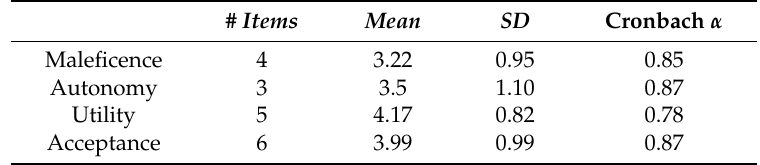
Table 2. Descriptive statistics of the four composite factors used for further statistical analyses ( N = 357). # Items Mean SD Cronbach α Maleficence 4 3.22 Autonomy Utility 5